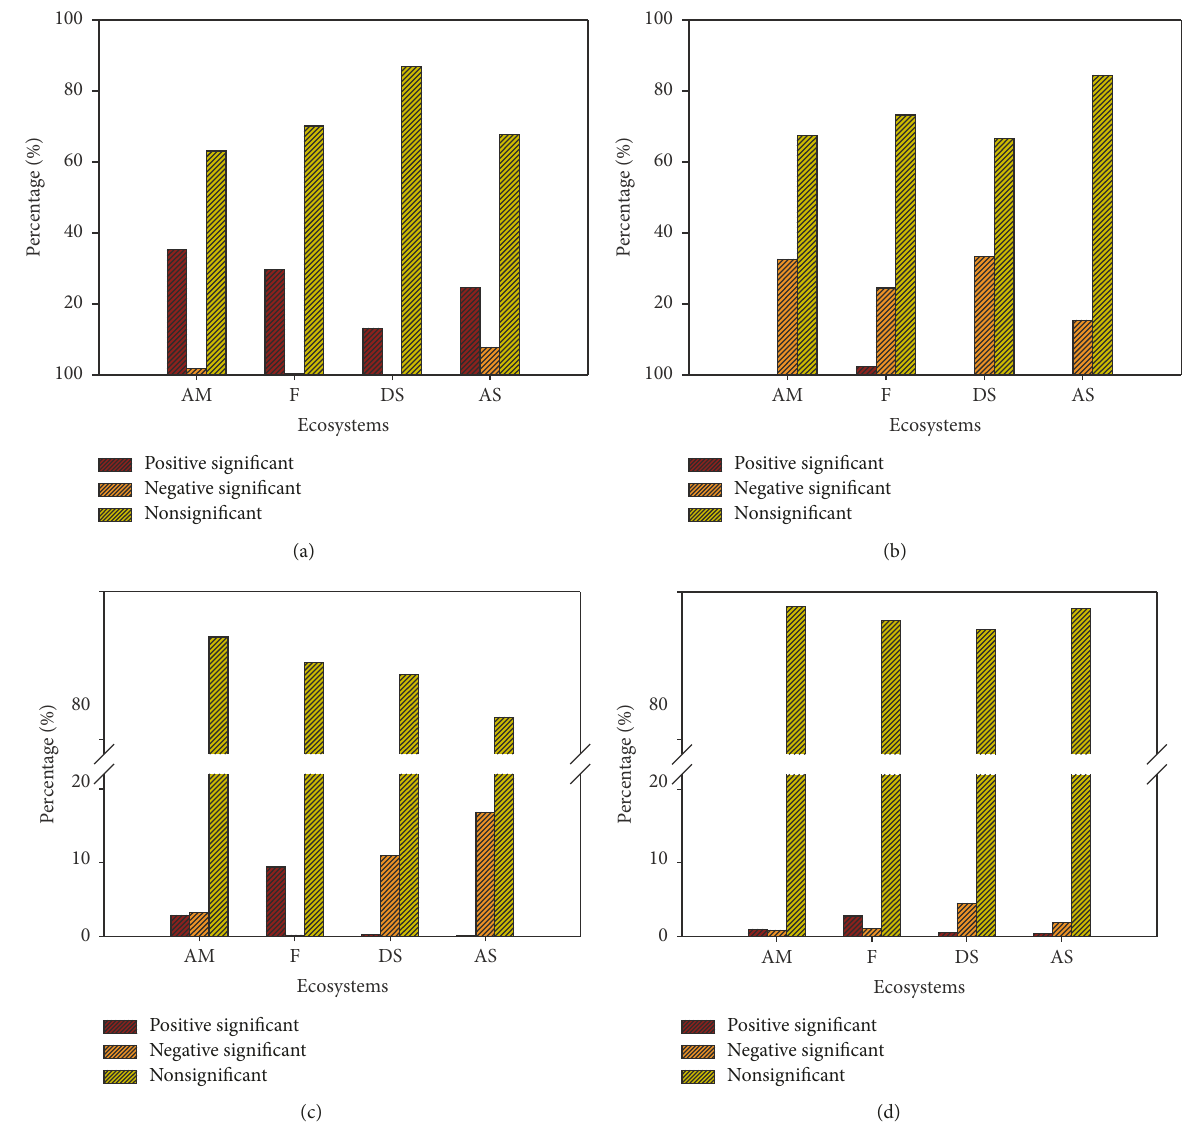
Figure 6: The percentage of significant changes of ET with four environmental factors across the Tibetan Plateau. Graphs (a), (b), (c), and (d) represent the variation with temperature, precipitation, radiation, and NDVI, respectively. Furthermore, alpine meadow, forest, desert steppe, and alpine steppe are represented by AM, F, DS, and AS,